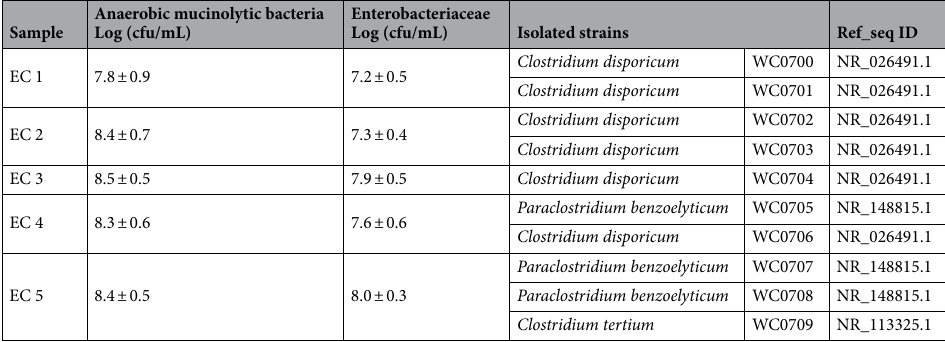
Table 1. Cultivable mucin degraders in EC samples.The viable counts of anaerobic mucinolytic bacteria and Enterobacteriaceae, respectively counted onto plates of MM medium and MacConkey, and the taxonomic attribution of the predominant anaerobic is reported. Counts are reported as mean Log (cfu/mL) ± standard deviation, n = 3. For both the media, no significant difference was observed among samples (ANOVA, P > 0.05). Cultivable anaerobic mucinolytic bacteria were significantly more numerous than Enterobacteriaceae (paired samples t-test, P < 0.05). Taxonomic attribution was obtained by alignment of the V1–V4 regions of 16S rRNA gene with the NCBI refseq_rna database using BLAST. The accession number of best hits and the sequence identity (%) obtained with MUSCLE are